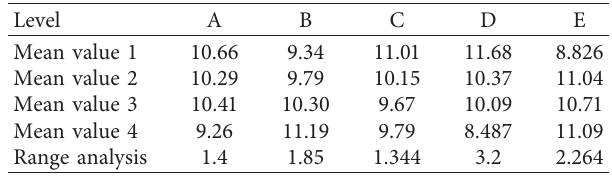
Table 7: Warpage range analysis (mm).